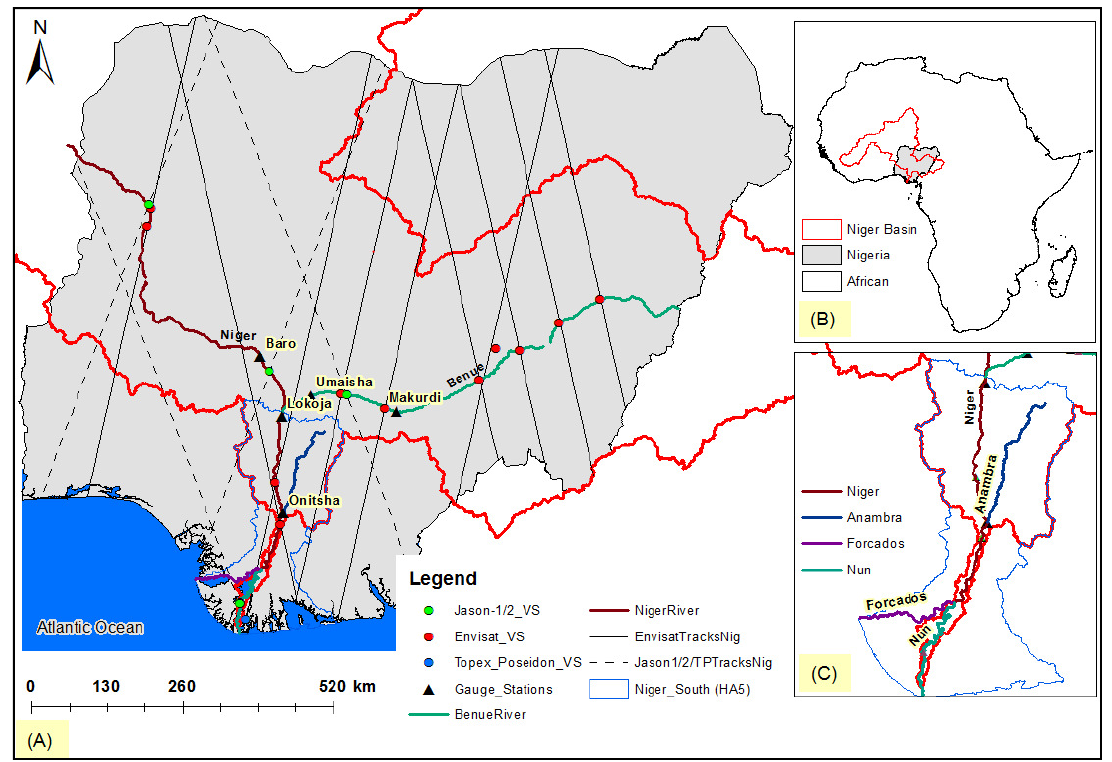
Figure 1. ( A ) Map of Nigeria showing in situ gauging stations, altimetry virtual stations and tracks along Niger and Benue Rivers. ( B ) Map of Africa showing Niger Basin imprint on Nigeria. ( C ) Niger South hydrological area showing tributaries (Niger and Anambra) and distributaries (Nun and Forcados).